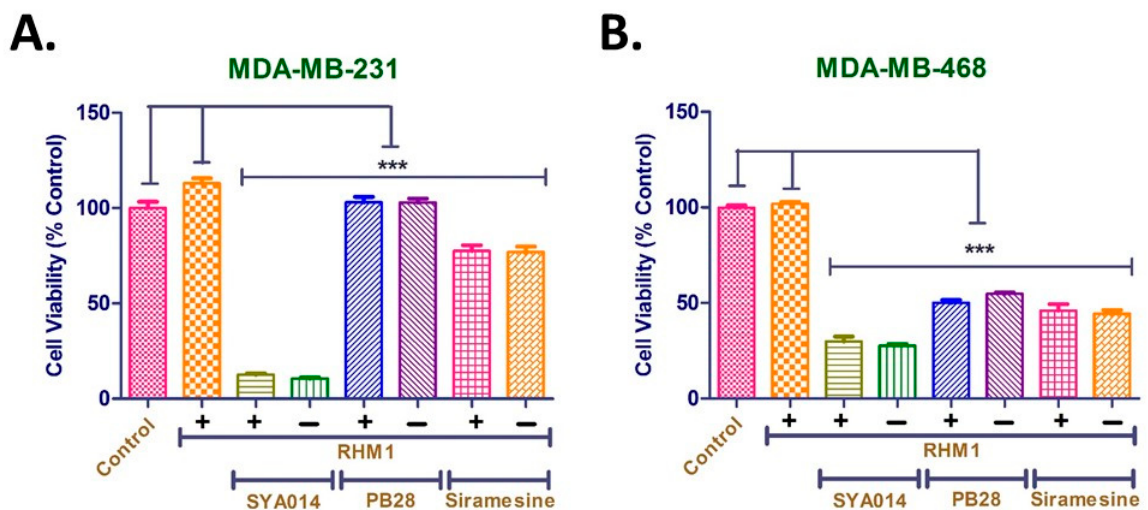
Figure 10. Role of the sigma-2 receptor ( σ 2R) on the cytotoxic property of SYA014 in MDA-MB-231 cells ( A ) and MDA-MB-468 cells ( B ) pre-treated with RHM-1 followed by the treatment with SYA014 for 24h. The cell viabilities were determined using resazurin reduction assay as described in the materials and methods section. Each experiment was performed in triplicate and the data points represents the mean ± SEM of 8 wells for each experiment. The results were plotted using GraphPad Prism version 5.0. *** p <0.001.